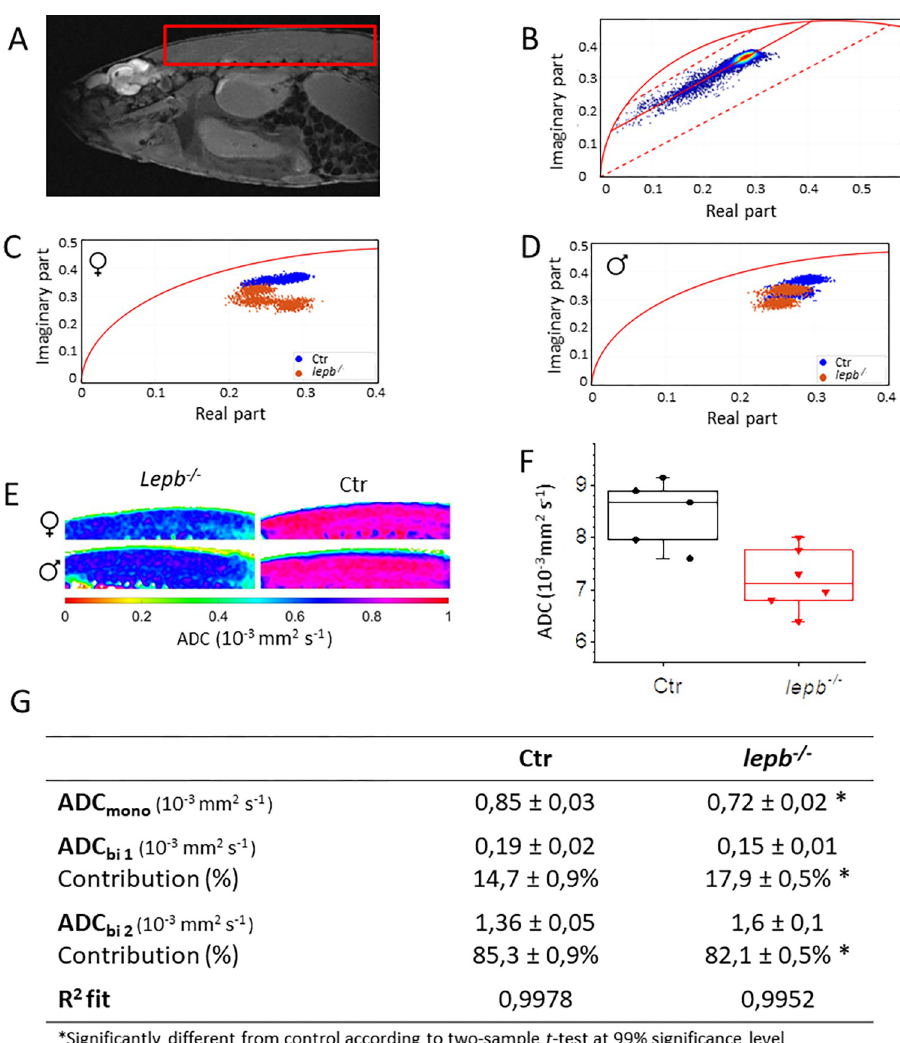
Fig 6. Phasor analysis of multislice 2D quantitative diffusion MRI datasets. (A) A diffusion image of a leptin- deficient ( lepb -/- ) zebrafish showing the region of interest (ROI), covering the muscle area. Voxels located outside the zebrafish were removed from the data-set by an intensity threshold. (B) Diffusion data from the ROI was transformed to phasor plot coordinates. Reference mono-component ADC values are located on the semi-circle (curved solid red line), ADC = 0 mm 2 s -1 is located at [0, 0] and increases non-linearly clock-wise. General shape indicates a multi- component diffusion system, more specifically a bi-component system. ADC components were determined by line fitting (solid red line) between specified borders (dotted red lines). (C) For smaller ROI’s in the muscle area, phasor coordinates are plotted to compare ADC in female and (D) male lepb -/- zebrafish with respective control (Ctr) zebrafish. (E) Mono-component ADC maps were created for female ( ♀ ) and male ( ♂ ) lepb -/- and Ctr zebrafish. (F) Quantification of ADC mono in Ctr and lepb -/- zebrafish. (G) Table of calculated ADC values in muscle area. for both female and male lepb -/- and control zebrafish as shown in Fig 6E. Based on these maps a significant difference between lepb -/- and control appeared (Fig 6E and 6F). Mono-compo- nent (ADC ) analysis of muscle tissue showed a significant difference (P < 0.01) between mono lepb -/- and control zebrafish (Fig 6E and 6G). However, no significant sex-specific difference was observed (Fig 6E). This indicates overall a lower diffusion in the muscle tissue of lepb -/- zebrafish compared to the control. As clear in Fig 6B, the muscle tissues show multi-